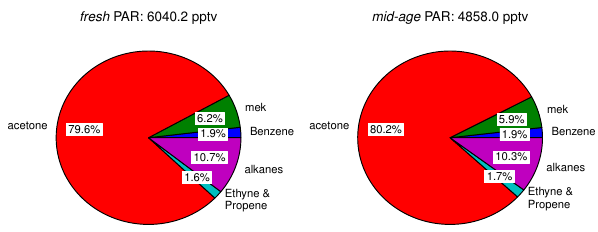
Fig. 6. Composition of CB05 PAR chemical mechanism species as measured during INTEX-NA in the median air parcel for fresh and young age